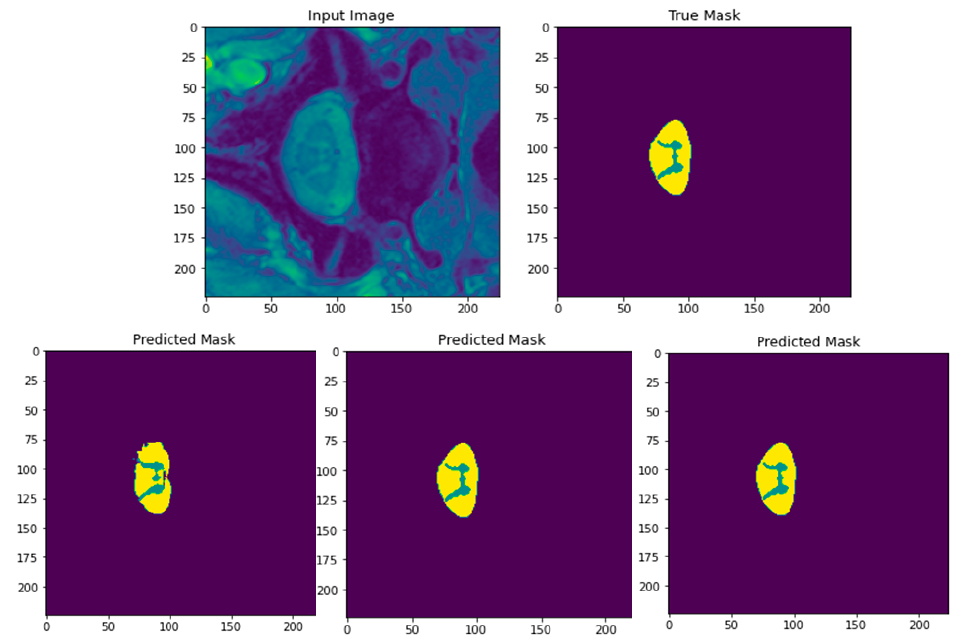
Figure 18. Original input image of SCGM and its corresponding ground truth mask (top row). Predicted masks after segmentation with the three employed batch sizes (bottom row from right to left: batch size = 8, 16, and 32, respectively). The RMSProp optimizer along with 400 epochs are adopted in these experiments.